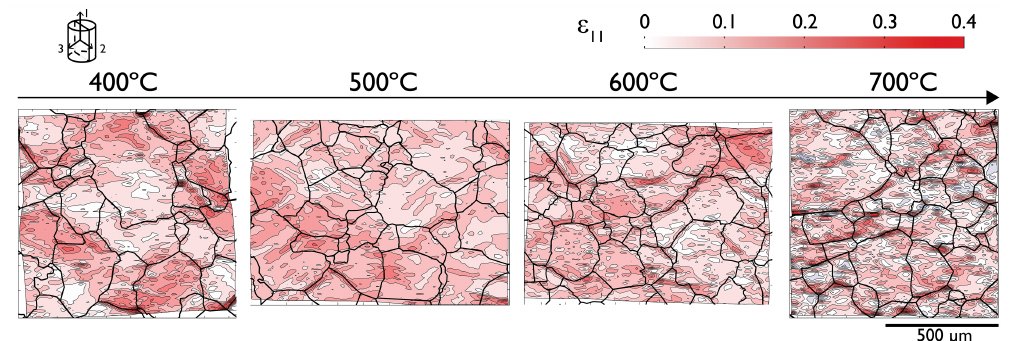
Figure 10. Strain maps for ε 11 computed with an n -point technique (with n = 9) for samples of Carrara marble deformed at T = 400, 500, 600, and 700 ◦ C, P c = 300MPa, and 3 × 10 − 5 s − 1 to 11% shortening strain. The strain component along the shortening direction is mapped with the overlaying grain boundaries. Shortening is positive. Note the concentration of strain along grain boundaries and intragranular features as T increases.